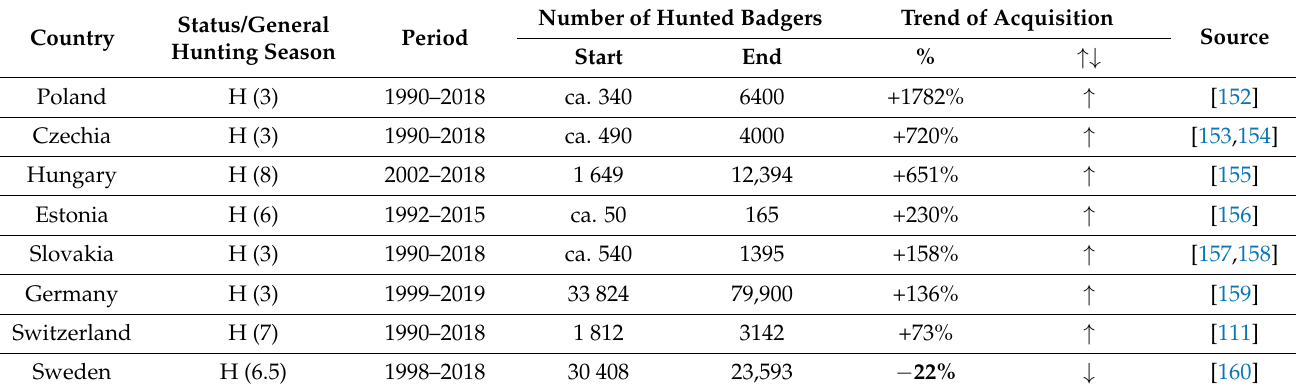
Table 3. Trends in European badger Meles meles hunting bag (decrease in bold). Status: P = protected all year round; H = hunted; U = unclear: game species not hunted but also not protected. The length of general hunting season given in brackets. For more detailed data see Table